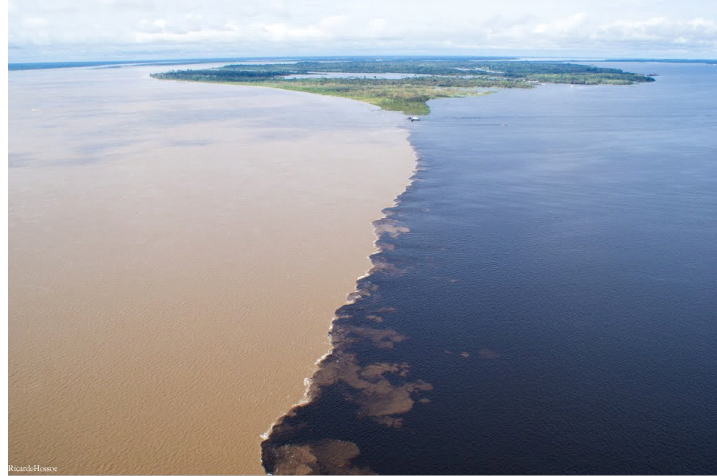
Figure 13. Oblique aerial photograph of the confluence of the Solimões and Rio Negro. Source: http://www.panoramio.com/photo/90000345.